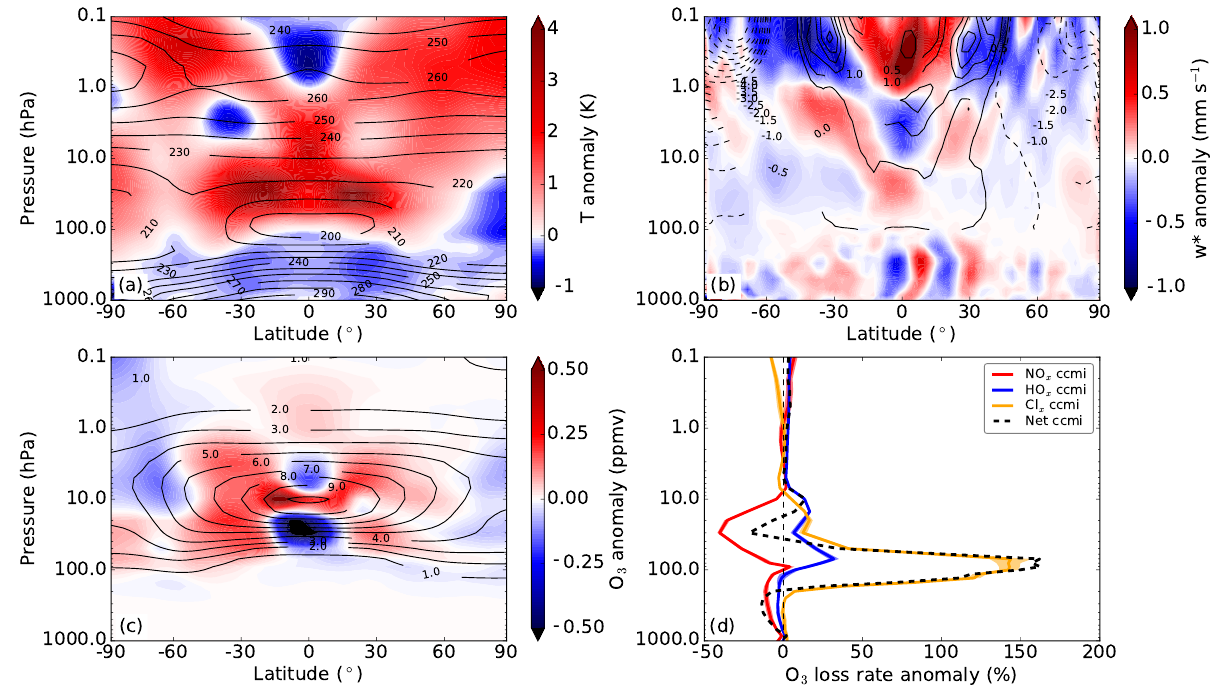
Figure 2. Ensemble-mean, zonal-mean anomalies averaged over the 6 months following the Mt Pinatubo eruption for the simulations using CCMI aerosol. (a) Temperature anomalies in the CCMI ensemble (red/blue shading). Black contours indicate the annual climatological mean (1986–2005) temperatures for the CCMI ensemble. (b) As (a) but showing anomalies in the rate of the vertical residual circulation ( w ∗ ). For clarity, the annual climatological mean rate of the vertical residual circulation (black contours) is only shown above 100hPa. Dashed contours indicate negative values. (c) As (a) but showing ozone anomalies. (d) Anomalies in tropical (15 ◦ N–15 ◦ S) ozone destruction rates by the NO x , HO x , and Cl x ozone destruction cycles. Negative anomalies indicate slower ozone destruction. Shading indicates the ensemble standard deviation. The dashed black line shows the sum of the NO x , HO x , and Cl x anomalies, i.e. the net anomaly in the ozone destruction rate following the